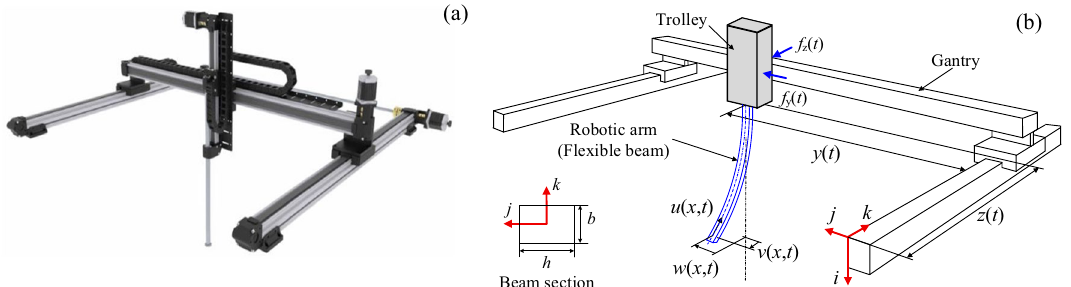
Figure 1. An example of nonlinear cantilever beams operating in the 3D space: ( a ) Gantry robot. (www.a- m-c. com/ servo- drives- for- gantry- syste ms), ( b ) the defined coordinate system and